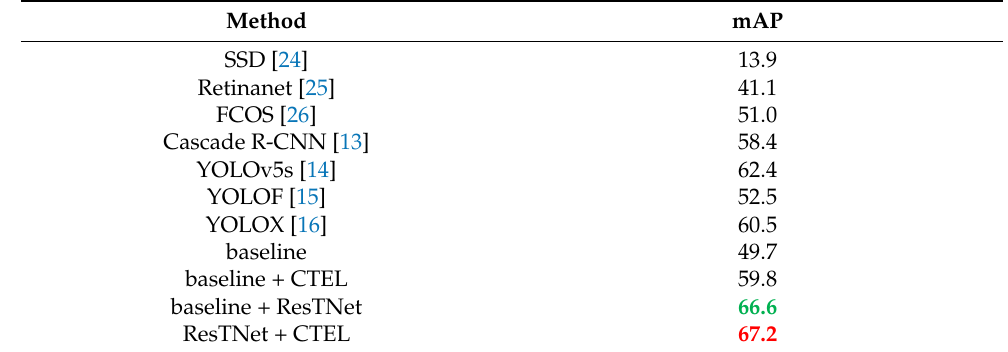
Table 4. The experimental results of various popular methods on our datasets are shown in tables. Top2’s mAP metrics is highlighted in red and